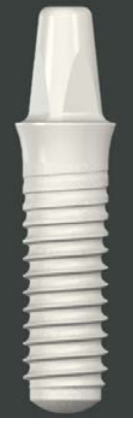
Figure 5. Monotype full ceramic ZrO 2 implant (Straumann ® PURE Ceramic Implant, Institut Straumann AG, Basel,